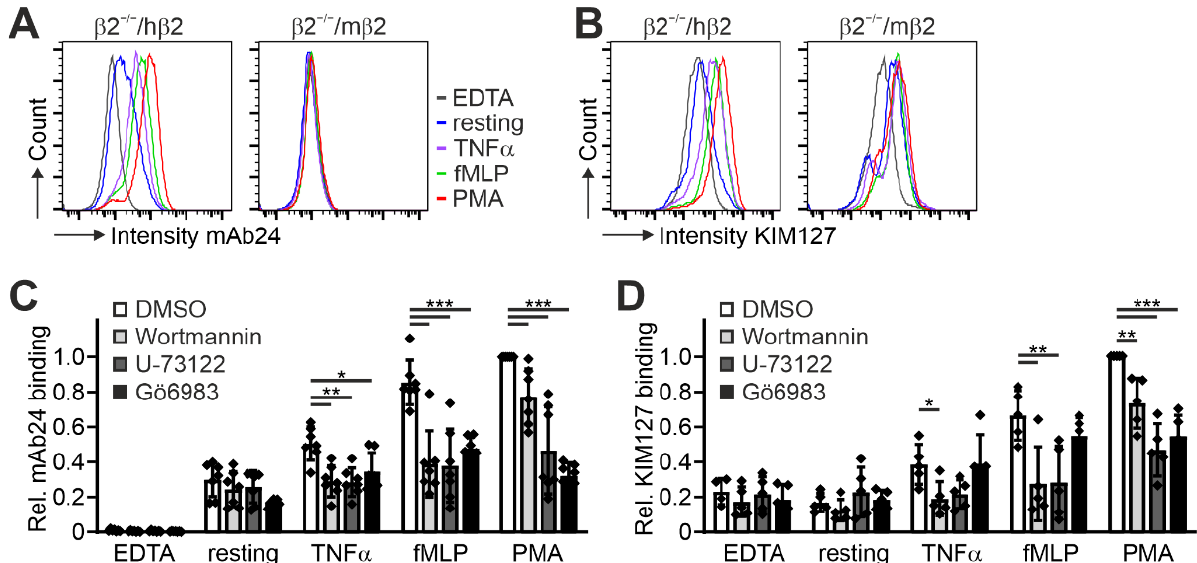
Figure 3. Expression of human integrin β2 in mouse integrin β2 −/− Hoxb8 cells allows assessment of integrin activity using conformation-specific anti-human integrin β2 antibodies. ( A , B ) FACS analyses of integrin β2 activation of Hoxb8-derived neutrophils expressing human or mouse integrin β2 by measuring staining intensities of conformation-specific antibodies mAb24 ( A ) and KIM127 ( B ) either untreated, EDTA-treated, or in response to TNF α , fMLP, or PMA. ( C , D ) Relative mAb24 ( C ) and KIM127 ( D ) binding to resting or EDTA-, TNF α -, fMLP-, or PMA-stimulated Hoxb8-derived neutrophil-like cells upon treatment with DMSO, the phosphatidylinositol-3-kinase (PI3K) inhibitor Wortmannin, the phospholipase C (PLC) inhibitor U-73122, or the protein kinase C (PKC) inhibitor Gö6983. N = 7 (mAb24) or 5 (KIM127) independent experiments, shown as individual data points. All values are given as mean ± SD. * p < 0.05, ** p < 0.01, *** p <